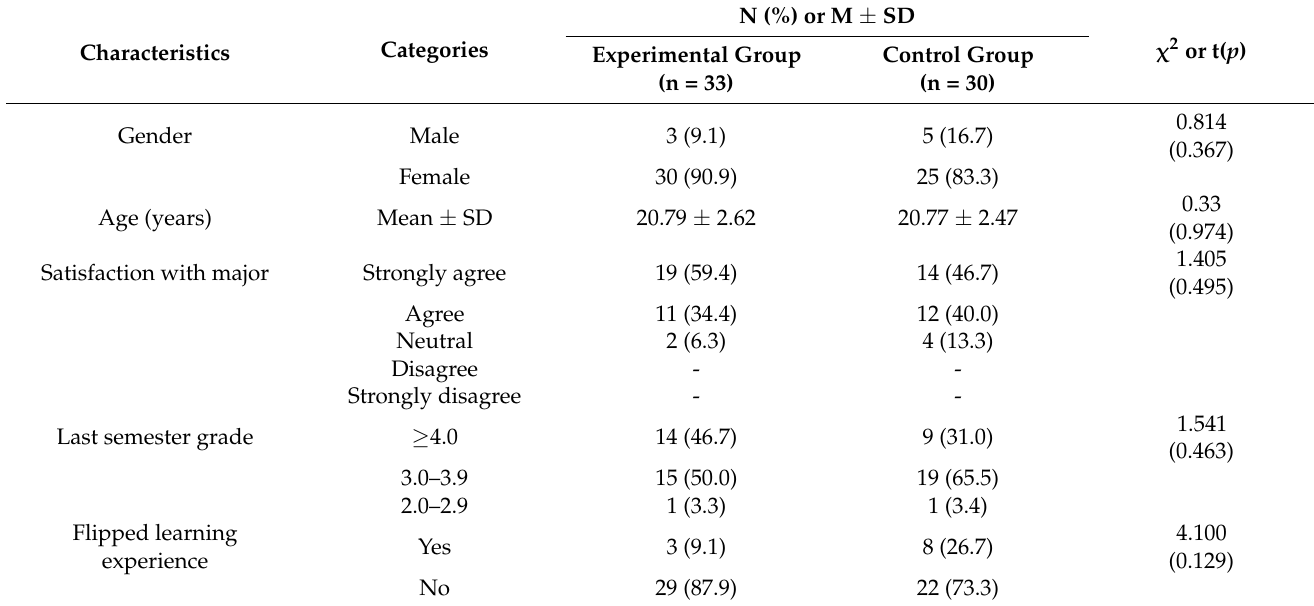
Table 2. Homogeneity between the experimental and control groups.